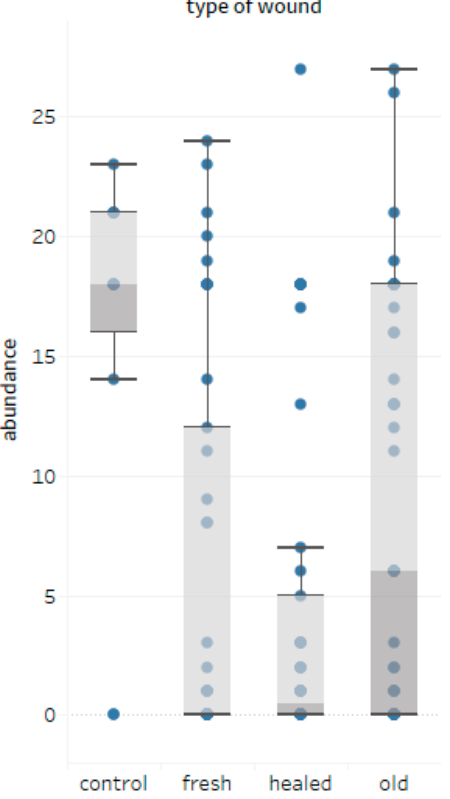
Table 3. Fungi colonies isolated from sapwood of bark-stripped Abies alba firs depending on wound type and habitation depth (O—outside part of wood; M—middle part of wood; H—the part near heartwood).